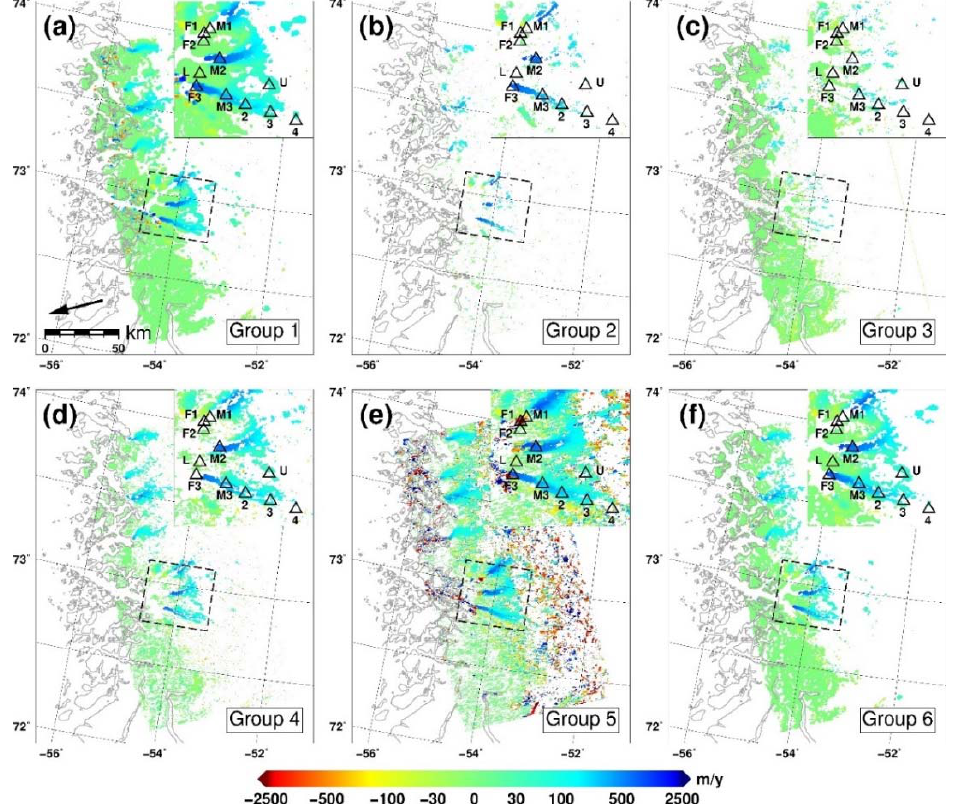
Figure 9. Task 3 LoS velocity maps provided by groups 1 to 6 ( a – f ). Positive values correspond to motion towards the radar along the LoS vector (from ground to satellite), the ground projection of which at scene center is shown by the arrow in ( a ). The insets correspond to the area in the dashed rectangle and show the GPS stations used for validation. Table 7. Task 3 main processing